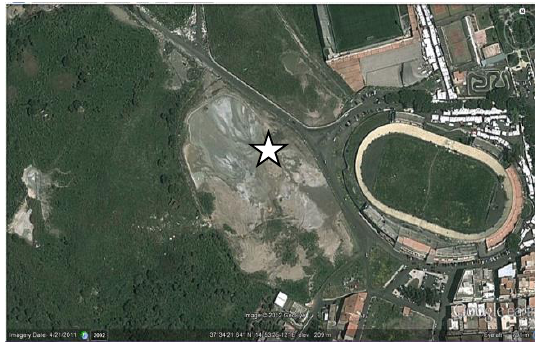
Figure 2. Le Salinelle mud volcano as seen by Google Earth (Lat 37.57298 Lon 14.89028) size in meters. The white star correspond to the location of take off and landing In this context the use of UAV can offer a good opportunity e to observe the overall thermal changes of the entire area and the pool spatial distribution.